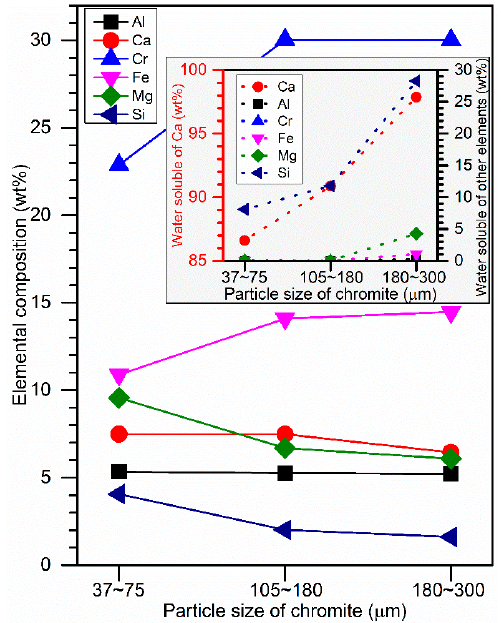
Figure 11. Elemental composition of the pellets reduced at 1300 °C, and the percentages of each element that are water-soluble (calculated based on Equation (2), and plotted as an inset).